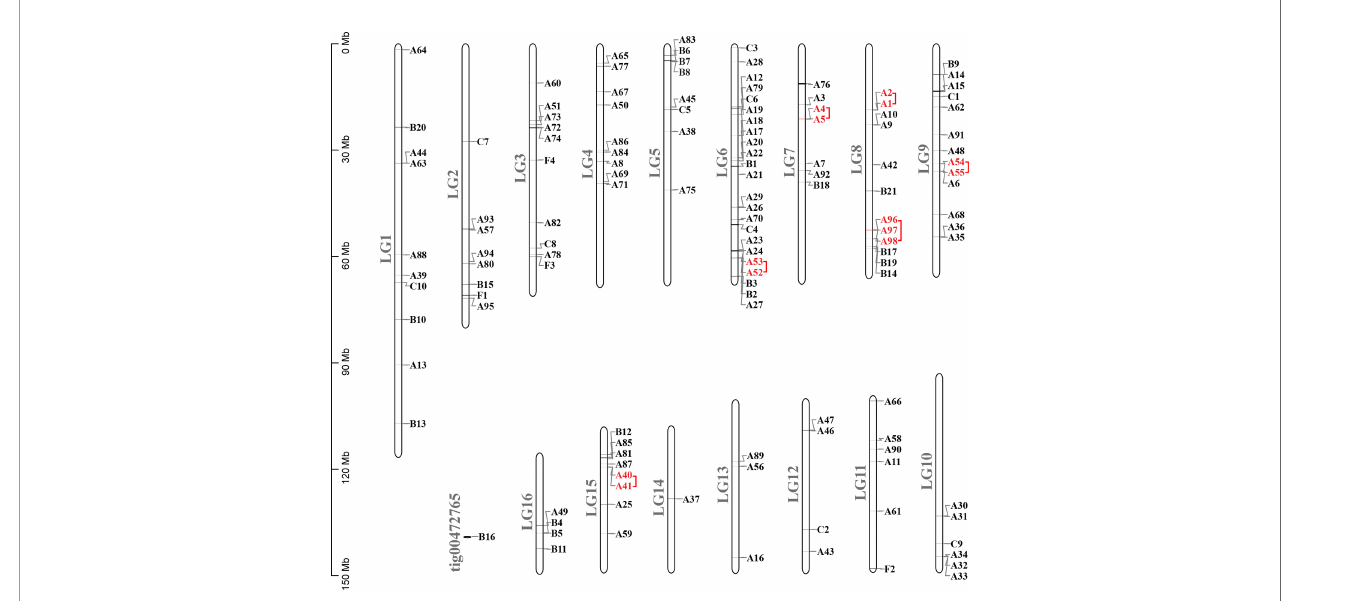
FIGURE 4 | Chromosomal locations and tandem duplicated gene pairs of the 133 putative GPCR genes. Each was mapped to the chromosome based on its physical location. The chromosome number (LG1 – LG16, tig00472765) is indicated at the left. The tandem duplicated genes were outlined with red color.